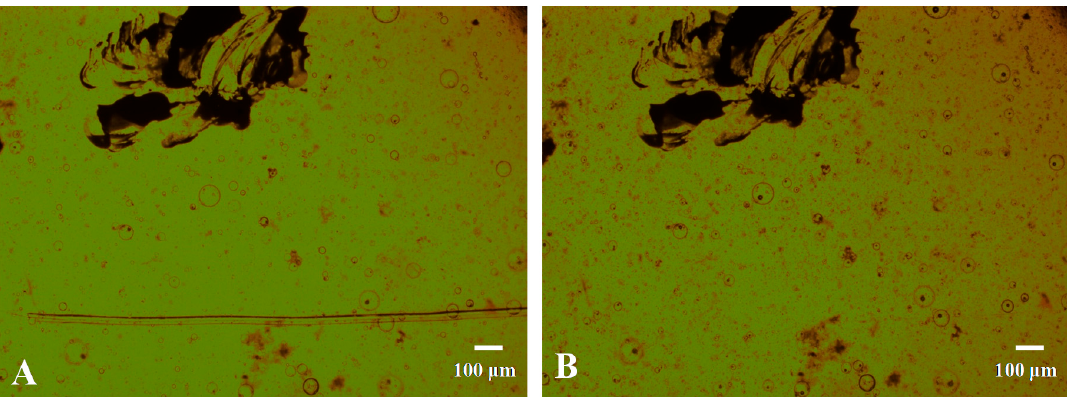
Figure 9. Optical microscope images of coating obtained from recovered DA polymer: ( A ) Damaged by scalpel scratching and ( B ) after thermal treatment at 120 °C and slow cooling to room temperature.